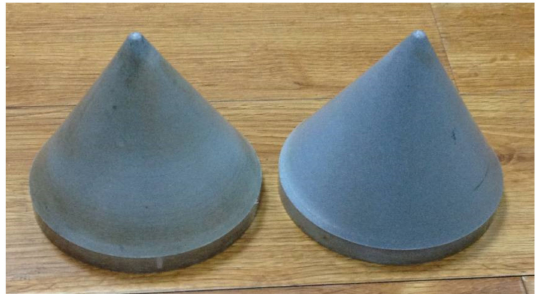
Figure 1. The reactive material liner.